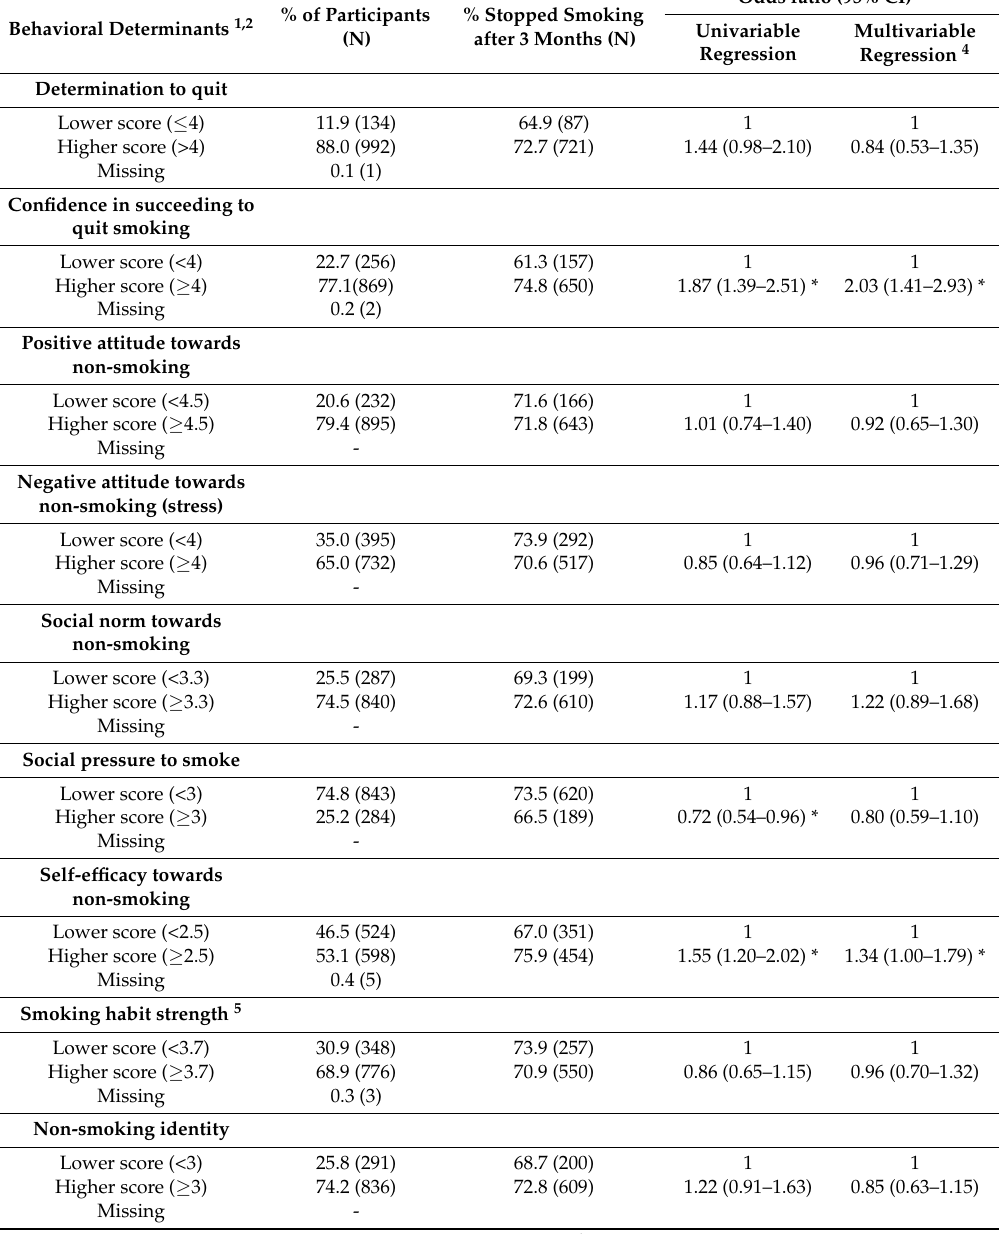
Table 3. Behavioral determinants at baseline and their association with not smoking after three months (N =